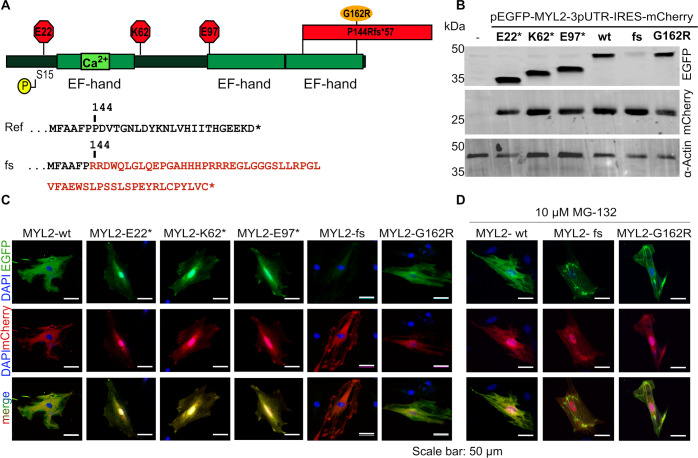
In vitro analysis of stability and localization of MYL2 variants.(A) Schematic of MYL2 protein showing N-terminal and C-terminal EF-hand domains along with Serine 15 residue that is target of MLCK phosphorylation, three stop-gain variants (red octagons), the frameshift variant identified in the proband (red block showing extension of C-terminal end) and missense variant associated with HCM (orange oval) in the C-terminal domain. The frameshift mutation changes the canonical MYL2 protein sequence (‘Ref.’, black text) from residue 144 onwards, modifying the last 20 amino acids of the protein in addition to adding 36 non-canonical amino acids to the C-terminus (‘fs’, red text). (B) Western blot image showing overexpression of EGFP-tagged MYL2 wildtype (wt) and variant proteins. The expression of the protein harboring the frameshift variant is significantly reduced while the other stop-gain variants do not show a significant change in expression. Analysis of mCherry signal by western blot does not show any significant changes between MYL2 wt and tested variants. Loading controls: mCherry and Actin. (C) In H9c2 cells, immunofluorescence analysis of EGFP tagged MYL2 wt and tested variants (green) that overexpress mCherry from the same transcript (red) is shown. EGFP-tagged MYL2-wt localizes to the cytoskeleton, while stop-gain variants (E22*, K62*, E97*) do not localize to the cytoskeleton and are observed in a diffuse pattern. EGFP signal from the frameshift variant (fs) is significantly reduced. Localization of the missense (G162R) variant is in a pattern similar to the wt. mCherry signal from the transfected cells does not change between variants. (D) Immunofluorescence images of EGFP-tagged MYL2-wt, MYL2-fs, and MYL2-G162R in MG-132 treated H9c2 cells show the rescue of MYL2-fs variant signal following MG-132 treatment (western blot of the rescue shown in S3B Fig). Scale bar indicates 50 μm length. Quantitation of signal from the western and immunofluorescence experiments is provided in S3B Fig.